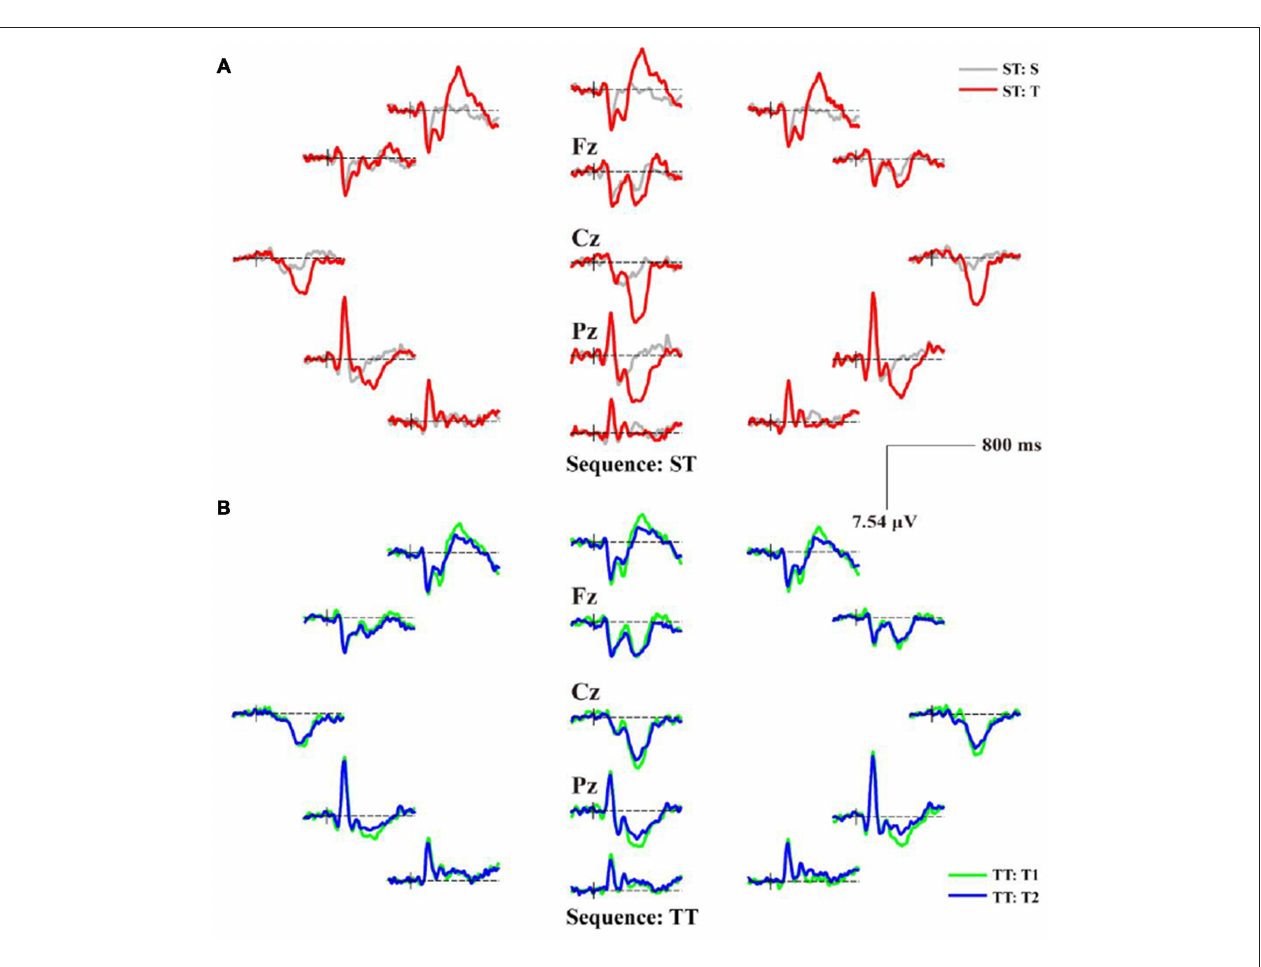
Frontiers in Human Neuroscience | www.frontiersin.org